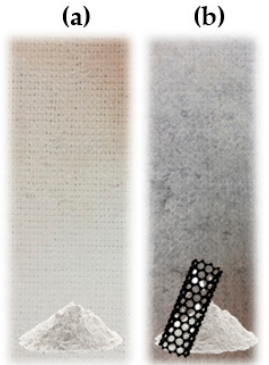
Figure 7. The image of photocatalysts: ( a ) TiO 2 photocatalytic film on glass fiber mesh, ( b ) TiO 2 /CNT photocatalytic film on glass fiber mesh.